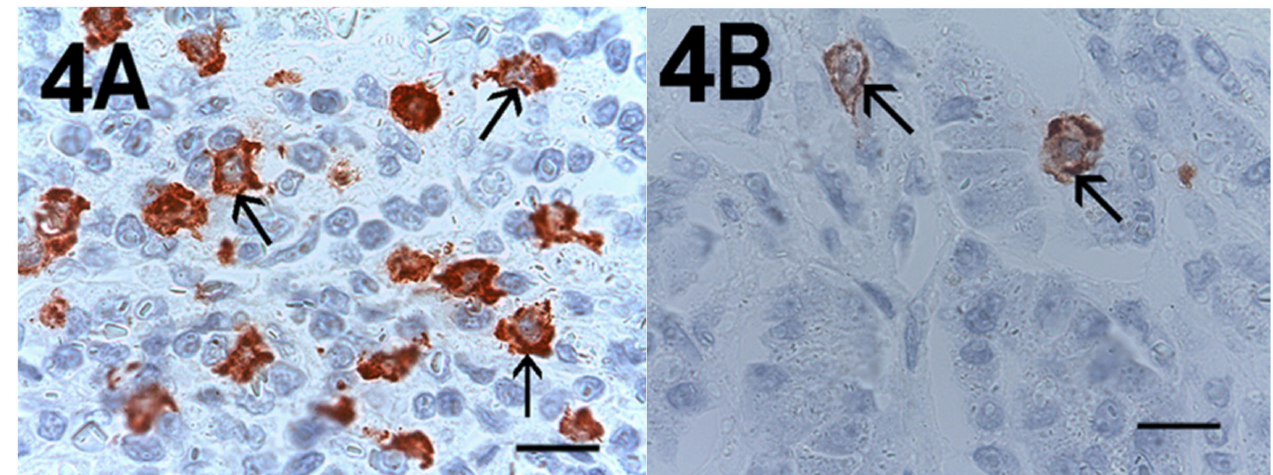
Figure 4. Magnification × 1000 in oil, 0.06 mm 2 area, immunostaining with the anti-CD117 antibody. ( A ) Very high MCDP- c-KitR in primary PDAT section. Small arrows indicate single red-immunostained MCs. The big arrow indicates tumour epithelium. ( B ) Low MCDP-c-KitR in ANT section. Small arrows indicate single red-stained mast cells. Please note the filiform membranes in immunostaining. Scale bar corresponds to 150 µ m.